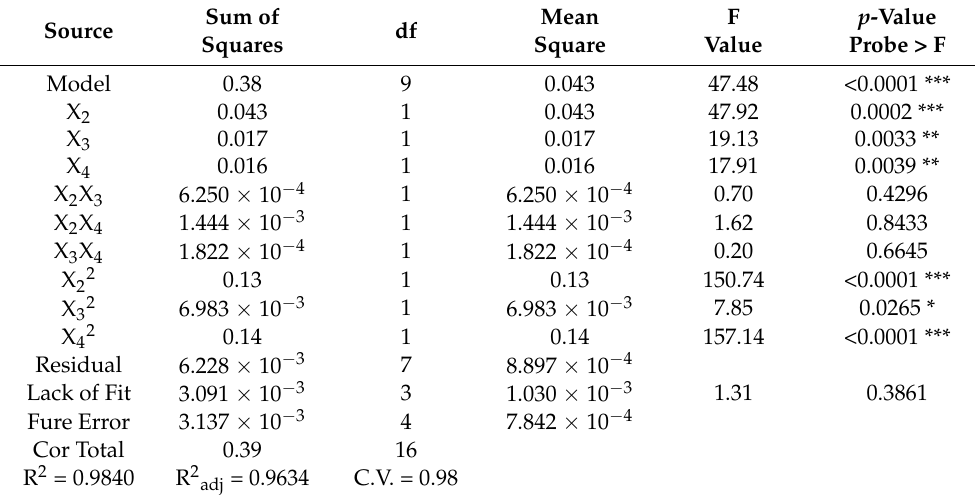
Table 4. Evaluation of the regression equation model coefficients and their significance